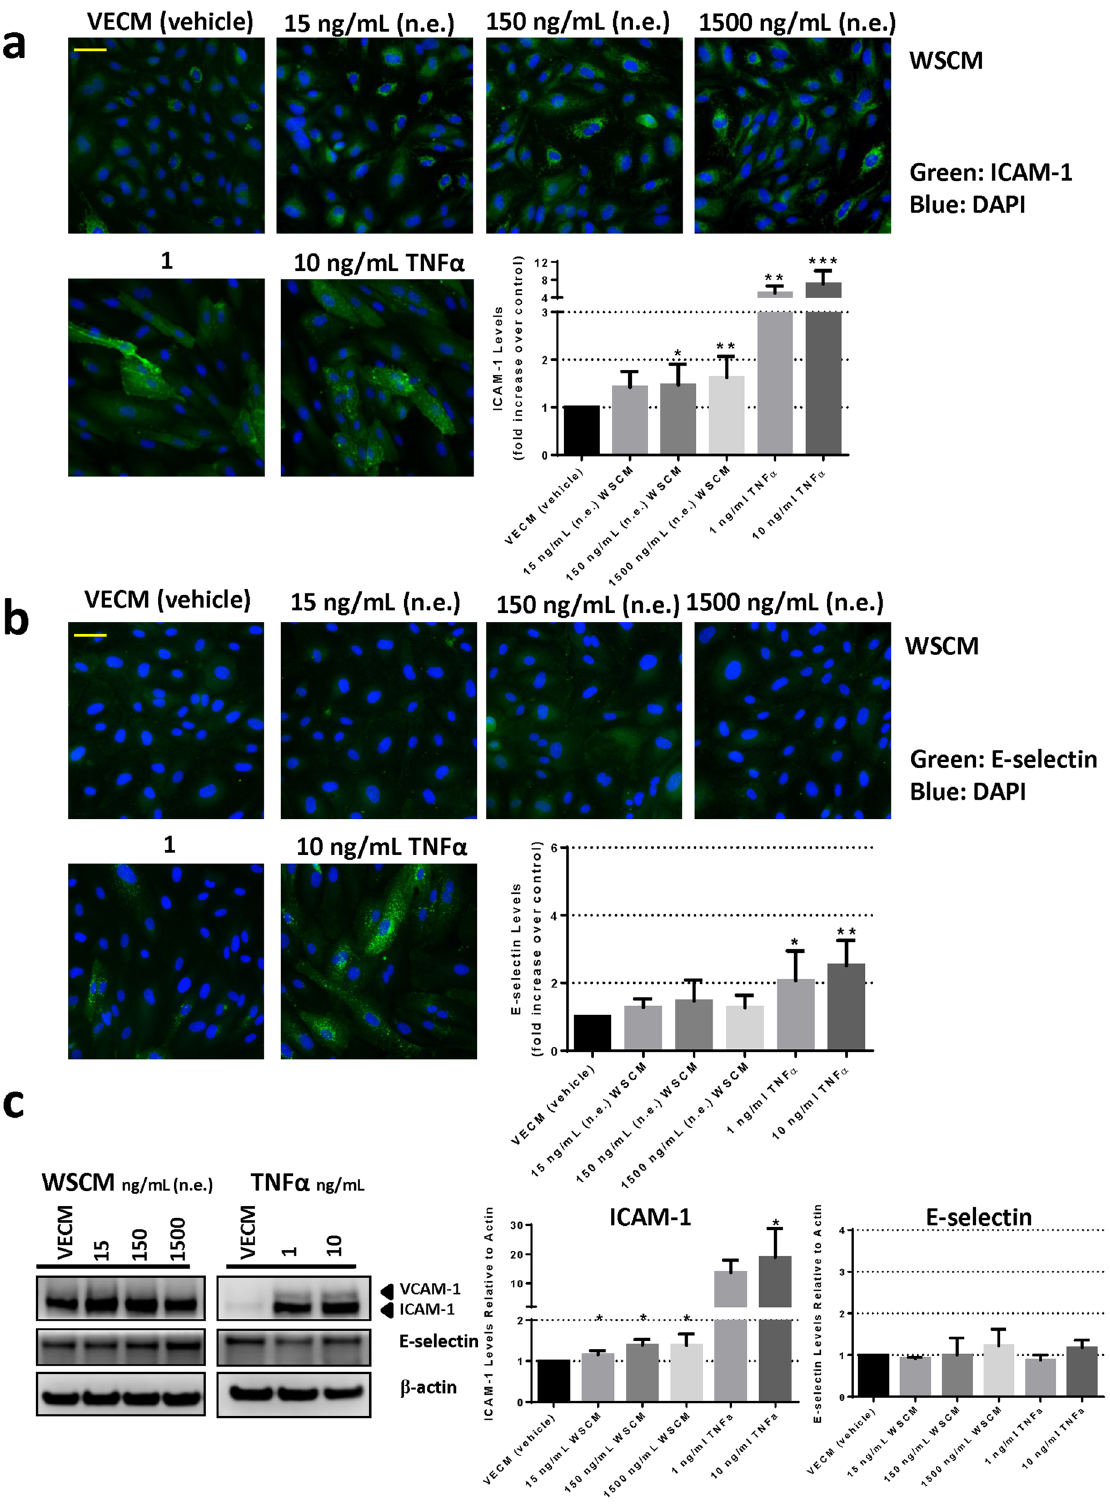
Figure 3. Analysis of ICAM-1 and E-selectin expression in HAECs following 24 h exposure to WSCM. ( a ) Immunofluorescence microscopy analysis and associated quantification of ICAM-1 or ( b ) E-selectin expression following HAEC exposure to WSCM for 24 h in Ibidi chamber slides. Images were captured using a Zeiss Axio Observer.Z1 microscope (×20 magnification). Scale bar (yellow line) = 70 µm. Errors bars denote ± SD (n = 6). ( c ) Western blot analysis and associated quantification of ICAM-1, VCAM-1 and E-selectin expression in HAECs following 24 h exposure to WSCM (refer to Supplementary Figure S1 for uncropped blots). One-way ANOVA with Dunnett’s multiple comparisons between vehicle control and each WSCM concentration. Error bars denote ± SD (n = 3); *p < 0.0 **p < 0.01 ***p <